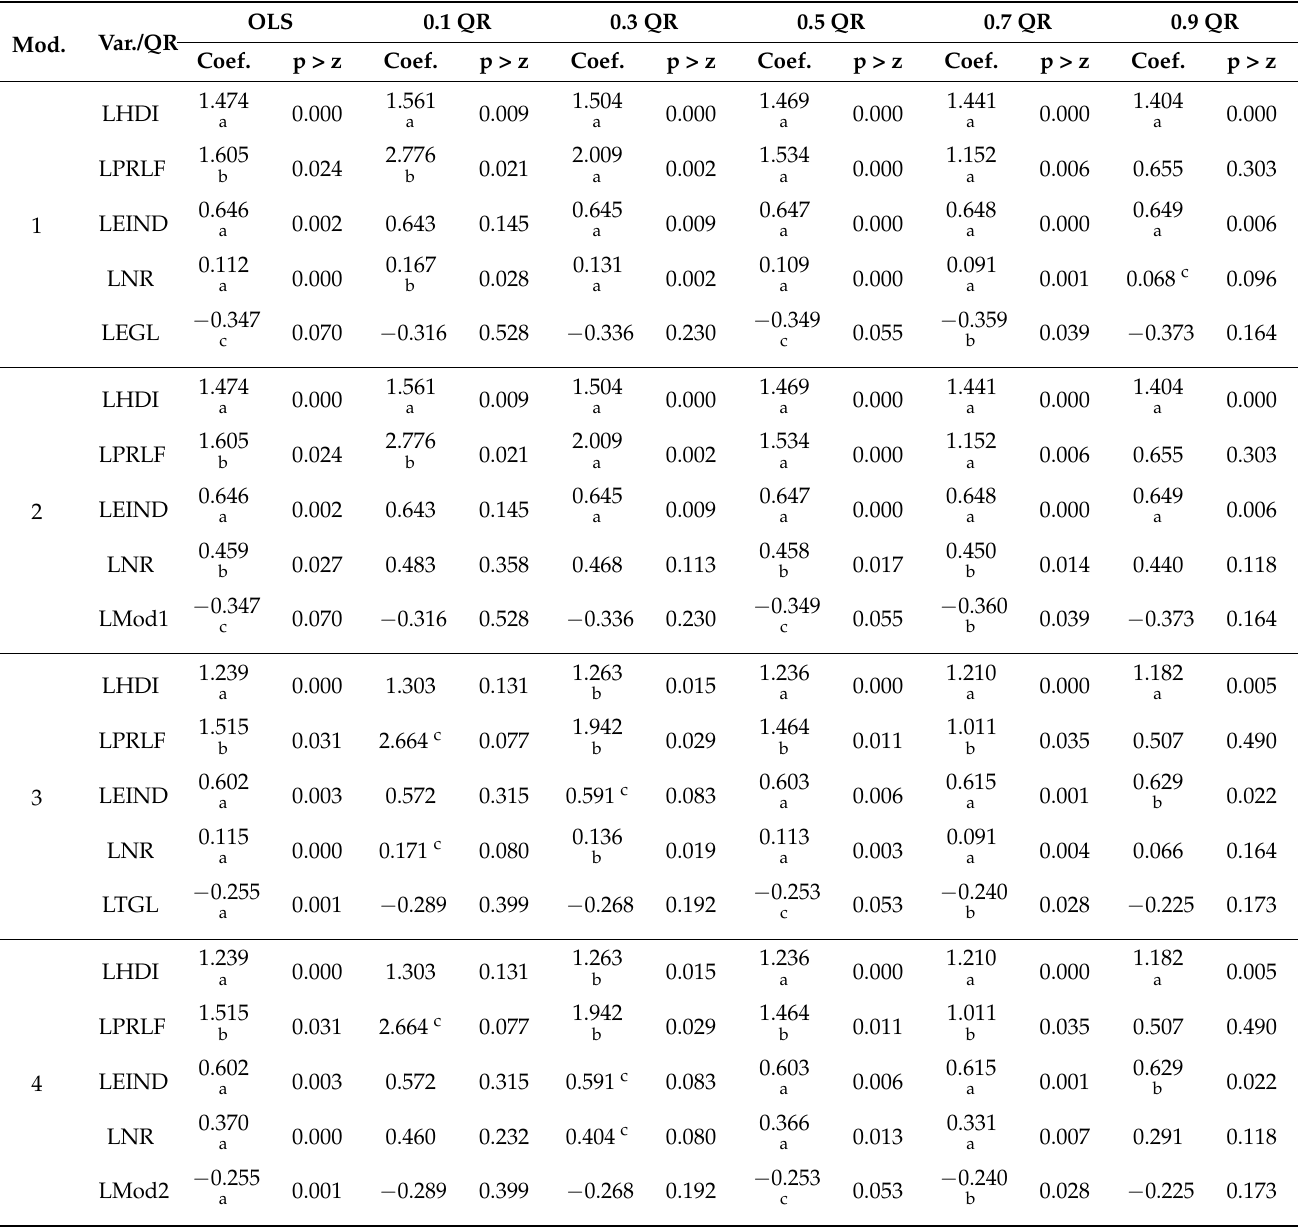
Table 6. Panel quantile regression model and ordinary least square